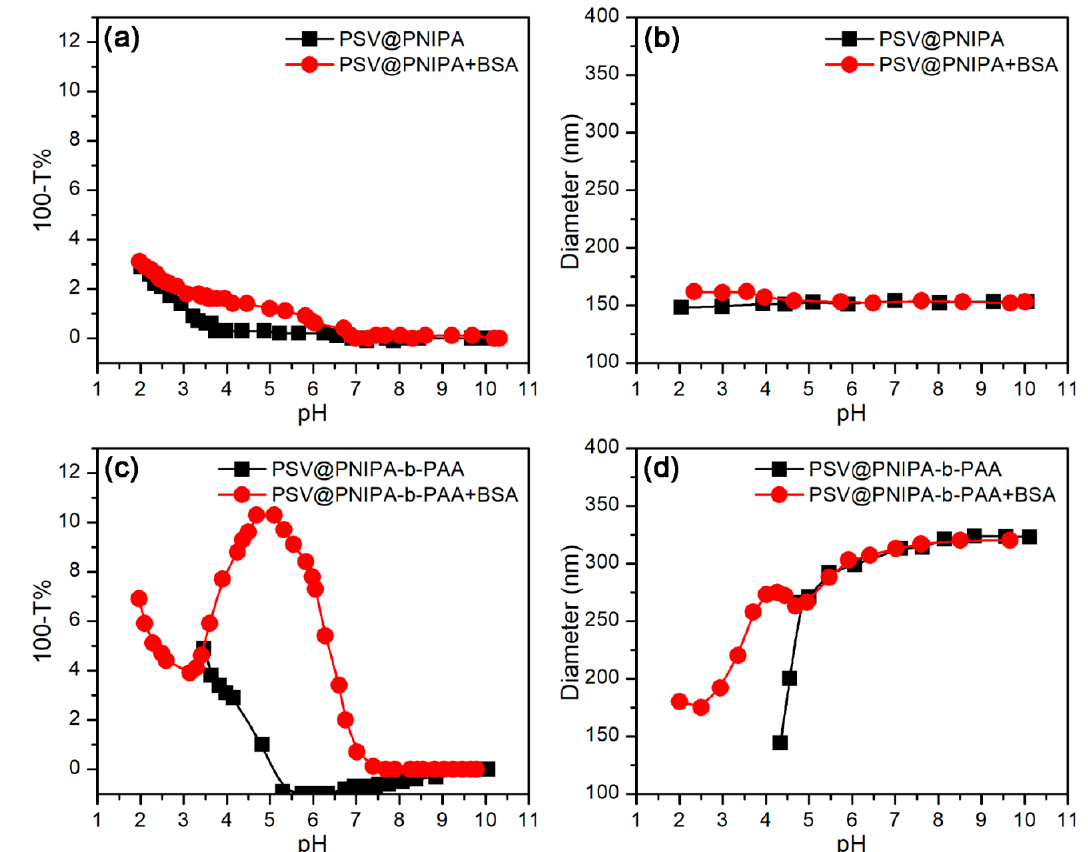
Figure 5. Effect of pH on protein adsorption in PSV@PNIPA and PSV@PNIPA- b -PAA via ( a , c ) turbidity and ( b , d ) hydrodynamic diameter change.